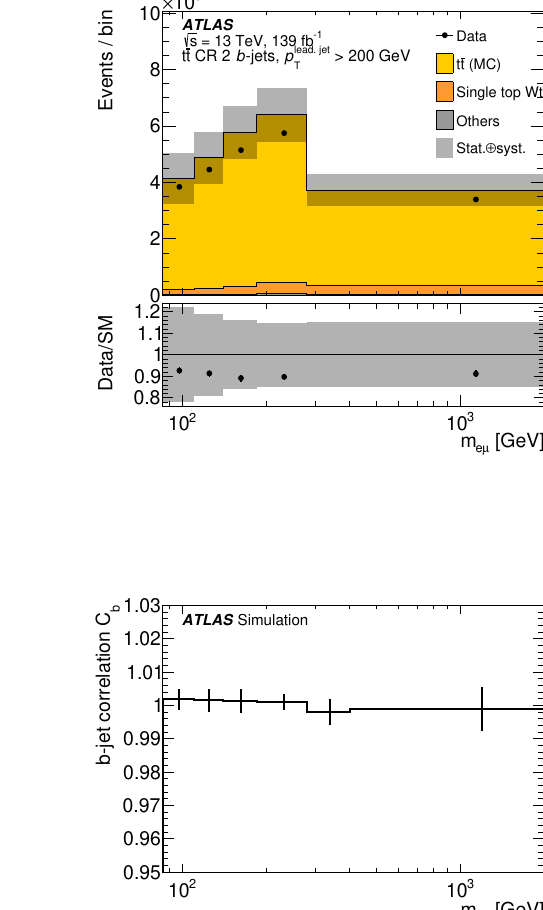
Figure 14 . Detector-level distributions of the dilepton invariant mass m eµ for p lead. jet in the one b -tag and two b -tag control regions as well as the top-enriched region, together with the b -jet correlation factor C b . The lower panels in the plots of detector-level distributions show the ratio of the data to the total prediction. The uncertainties shown include statistical and systematic uncertainties, for both the distributions and the correlation